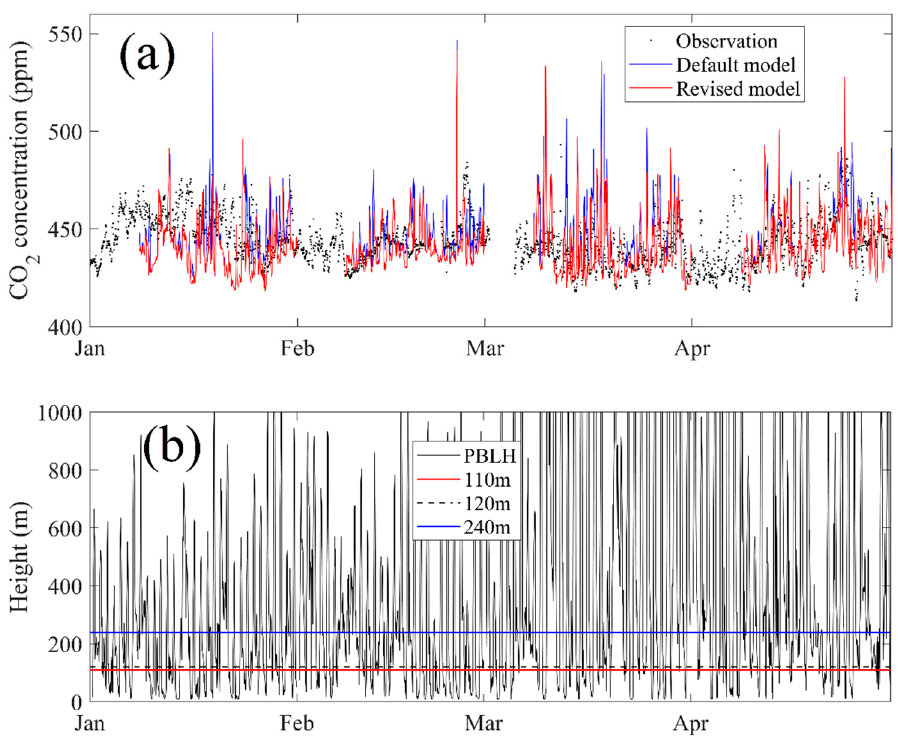
Figure 4. ( a ) Comparisons between hourly CO 2 concentrations and simulations (using both default and revised frameworks), and ( b ) the averages of hourly variations of simulated PBLH at three power station sites and the heights at three power stations, note the PBLH larger than 1000 m is not shown. As introduced in the Section 2, the simulated CO 2 concentration contains CO 2 back- plants NEE. In the whole study period, the simulated CO 2 enhancements from anthro- pogenic sources were 26.80 ppm for the default model and 22.02 ppm for the revised